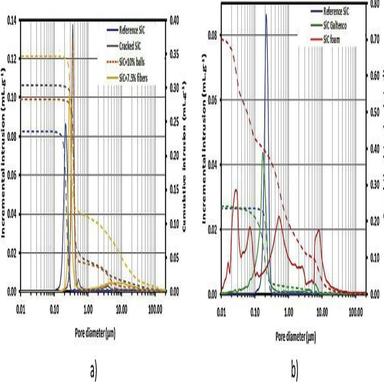
Pore-size distribution of the six SiC compacts types: a) for reference SiC, cracked SiC and SiC +10 %vol. balls, SiC+7.5 %vol. fibers; and b) reference SiC, SiC foam and SiC Galtenco.